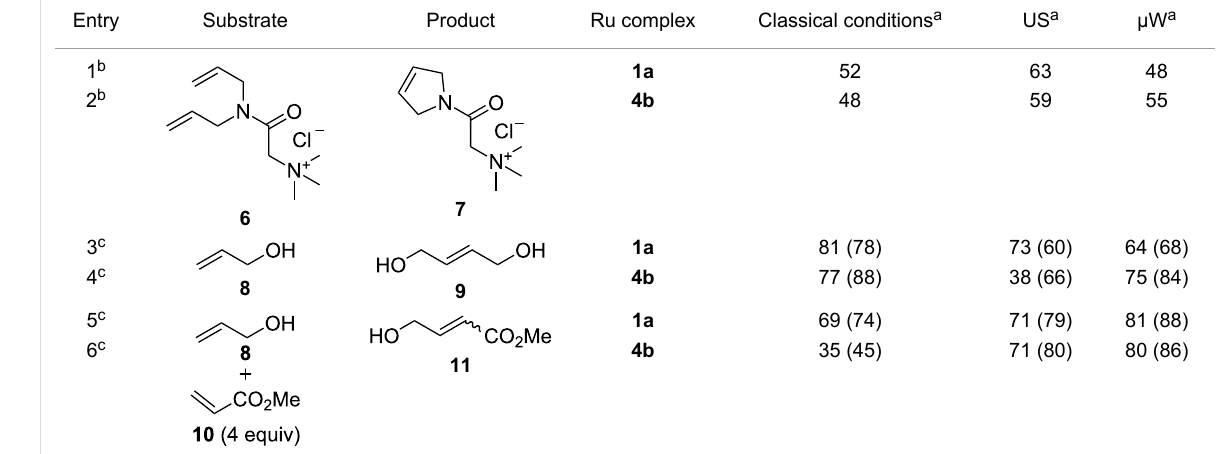
Table 1: Effect of microwave ( μ W) and ultrasound (US) irradiation on RCM, homometathesis and CM in water mediated by complexes 1a and 4b . Entry Substrate Product Ru